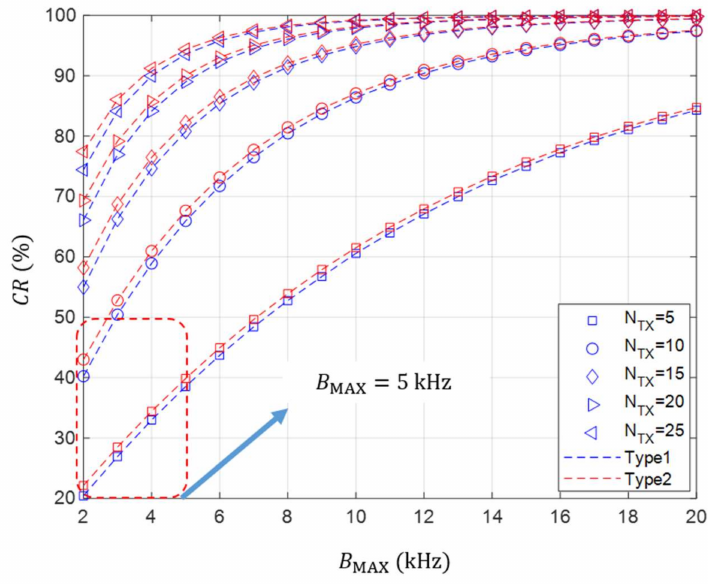
Figure 7. The collision rate according to the number of transmitting nodes and the maximum system bandwidth in case of ∆ f = 250